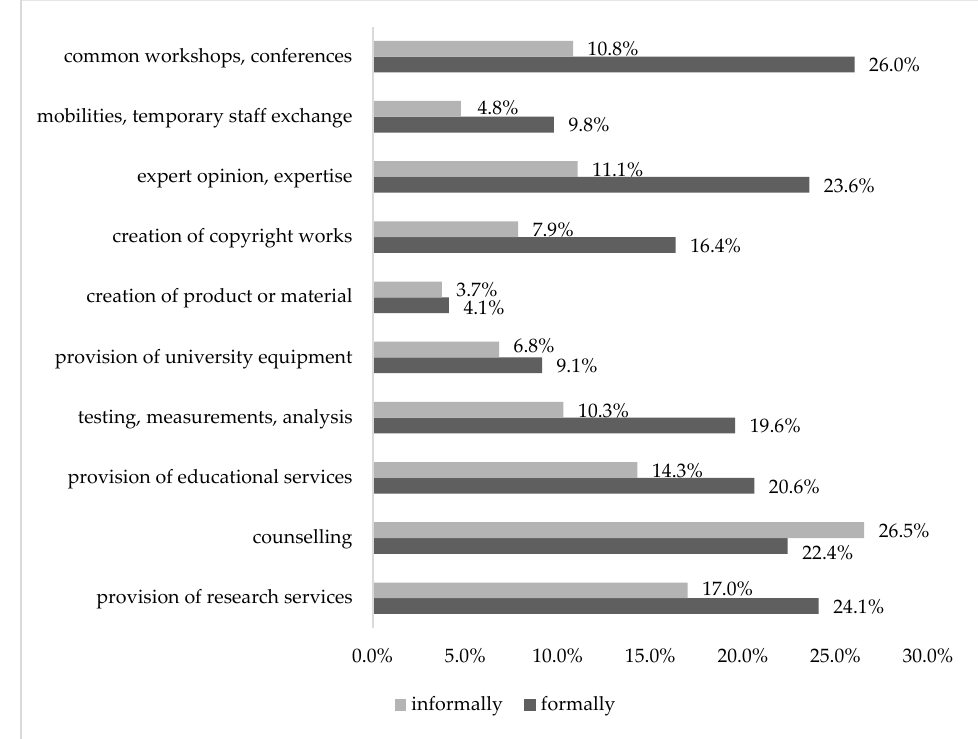
Figure 2. Share of academics using selected knowledge transfer channels formally or informally .